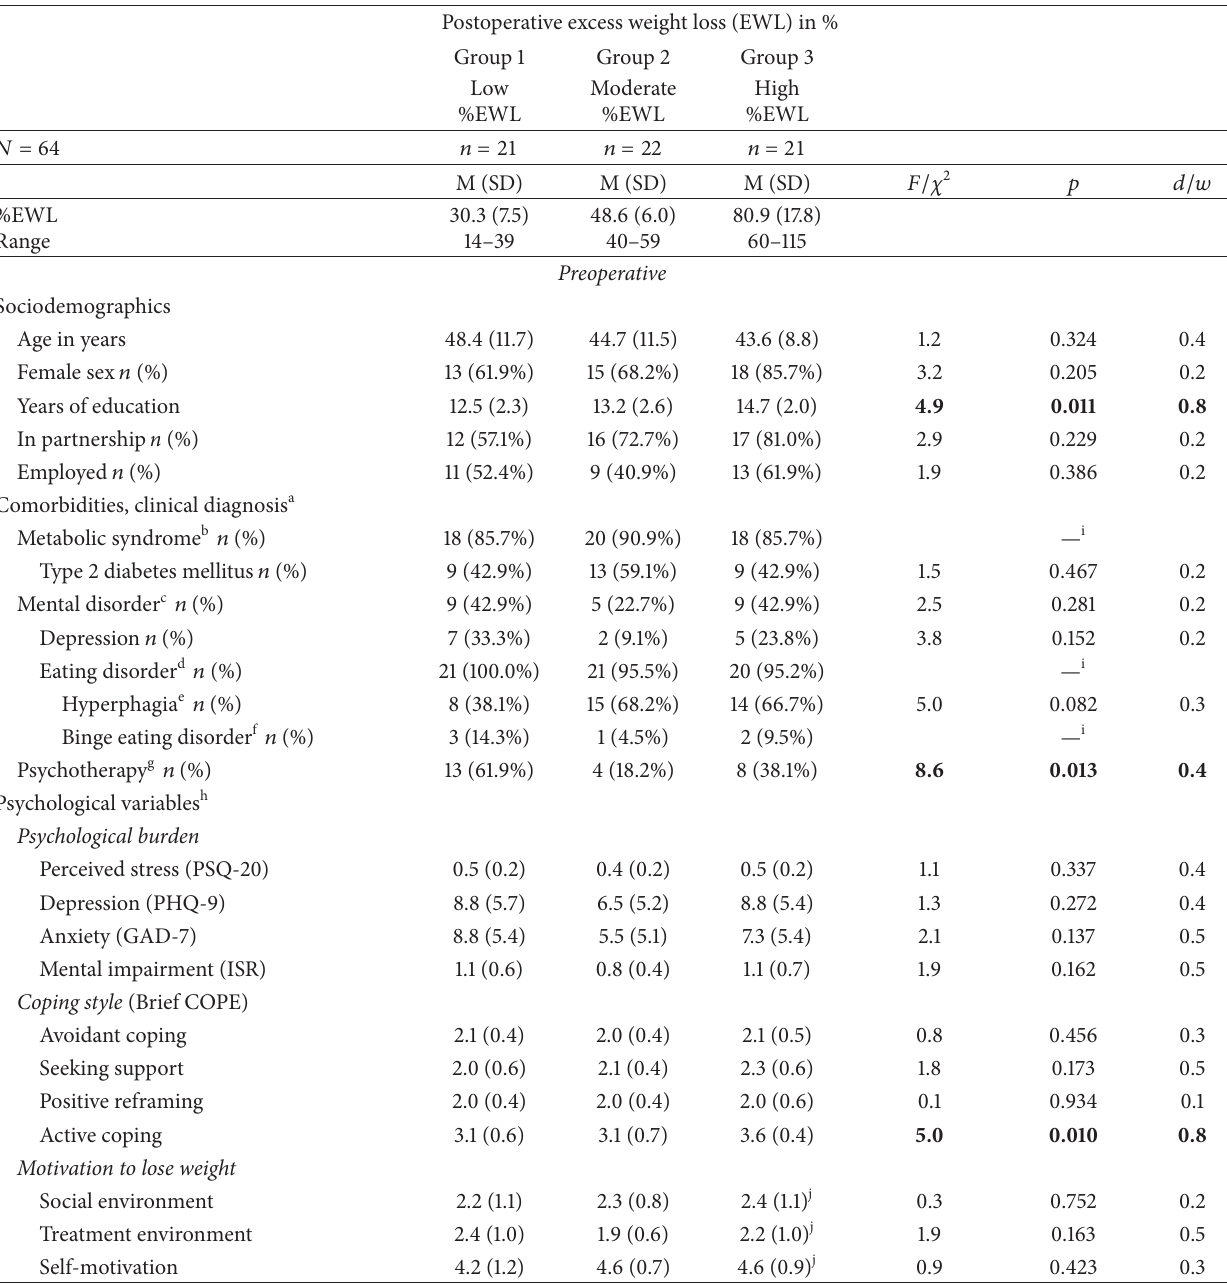
Table 2: Sociodemographics, comorbidities, and psychological characteristics before laparoscopic sleeve gastrectomy